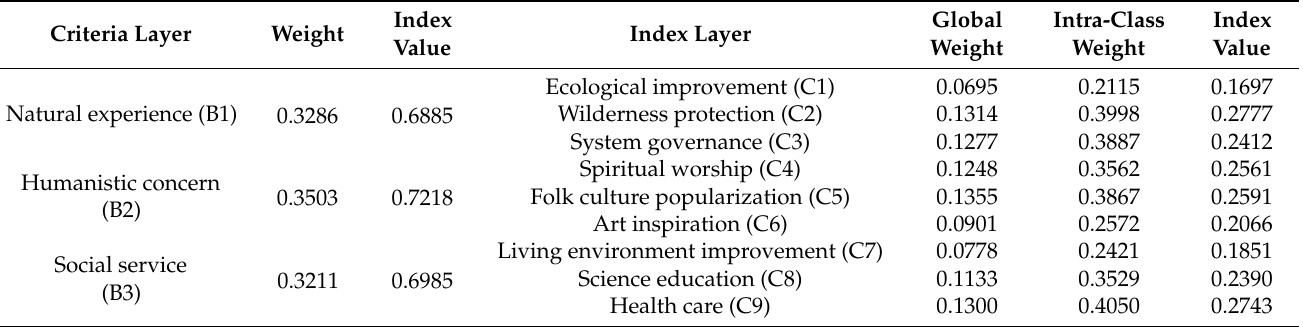
Table 6. Index weights for cognition evaluation of cultural ecosystem services of community